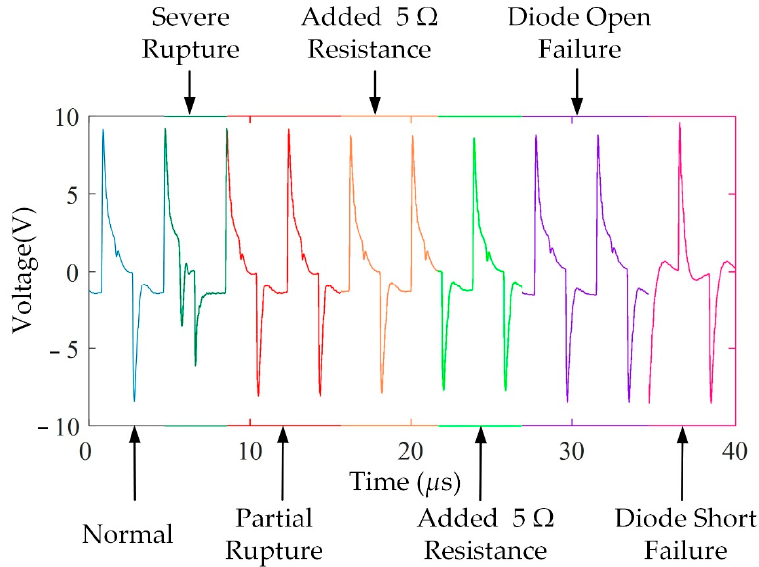
Figure 17a–d. The drawn normalized CDEM e 1 e 3 is shown in Figure 18a–d. The drawn normalized CDEM e 2 e 3 is shown in Figure 19a–d.